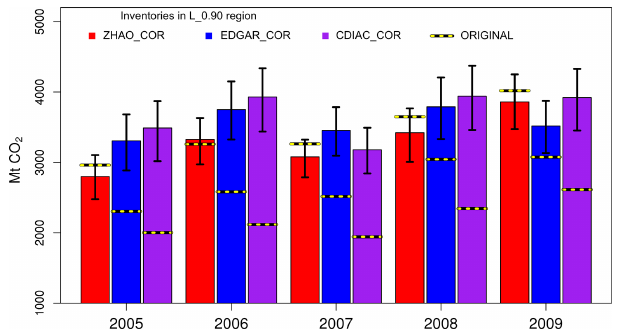
Figure 8. Annually scaled emissions in the L_0.90 region. Scaling is based on multiplicative scaling factors. Difference among scaled inventory means is due to differing spatial allocations in original anthropogenic inventories. Bootstrapped 95% confidence intervals are represented by the black vertical lines. ∗ Note the y axis origin begins at 1000MtCO 2 for visual